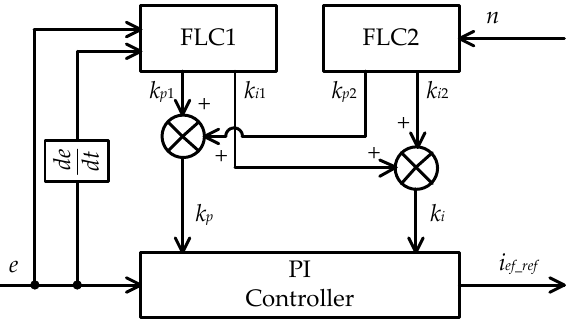
Figure 8. Block diagram of the proposed dual fuzzy PI controller.